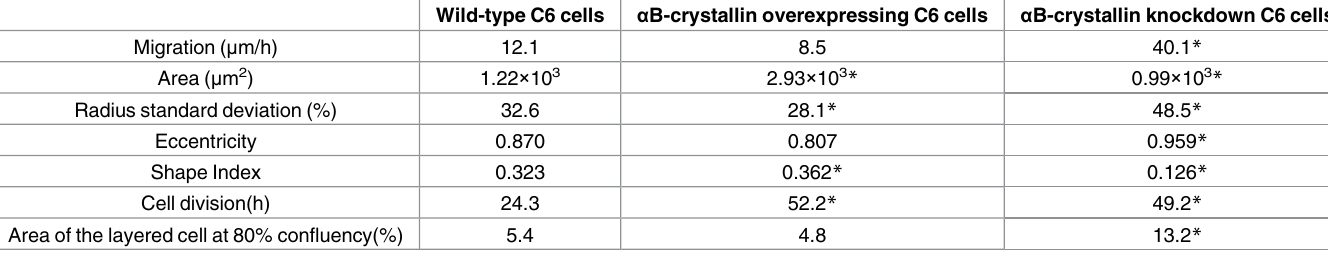
Table 1. α B-crystallin-dependent cell characteristics in rat C6 glioma cells.